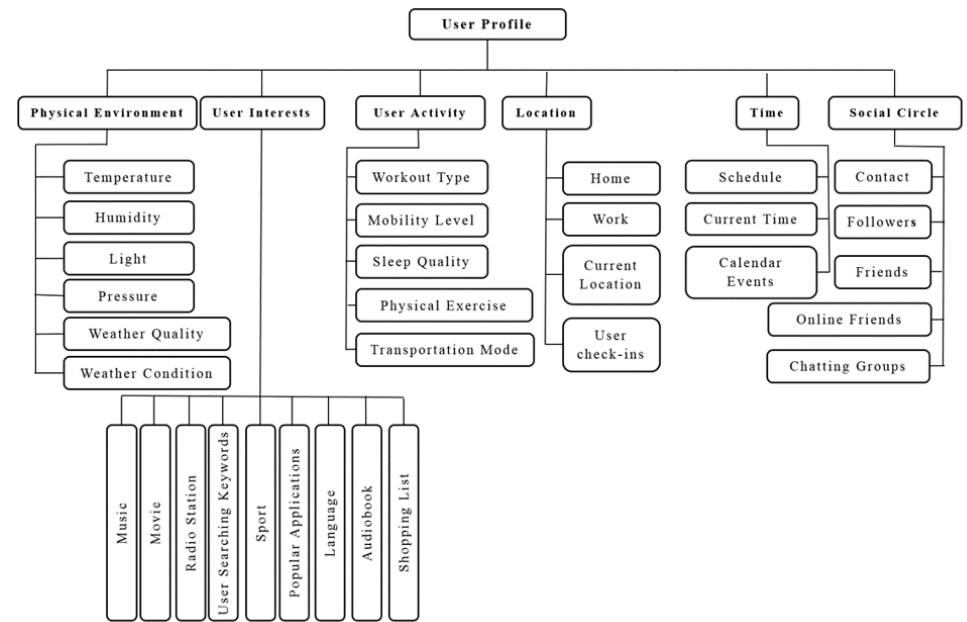
Figure 2. Context categorization applied to create the user profile.